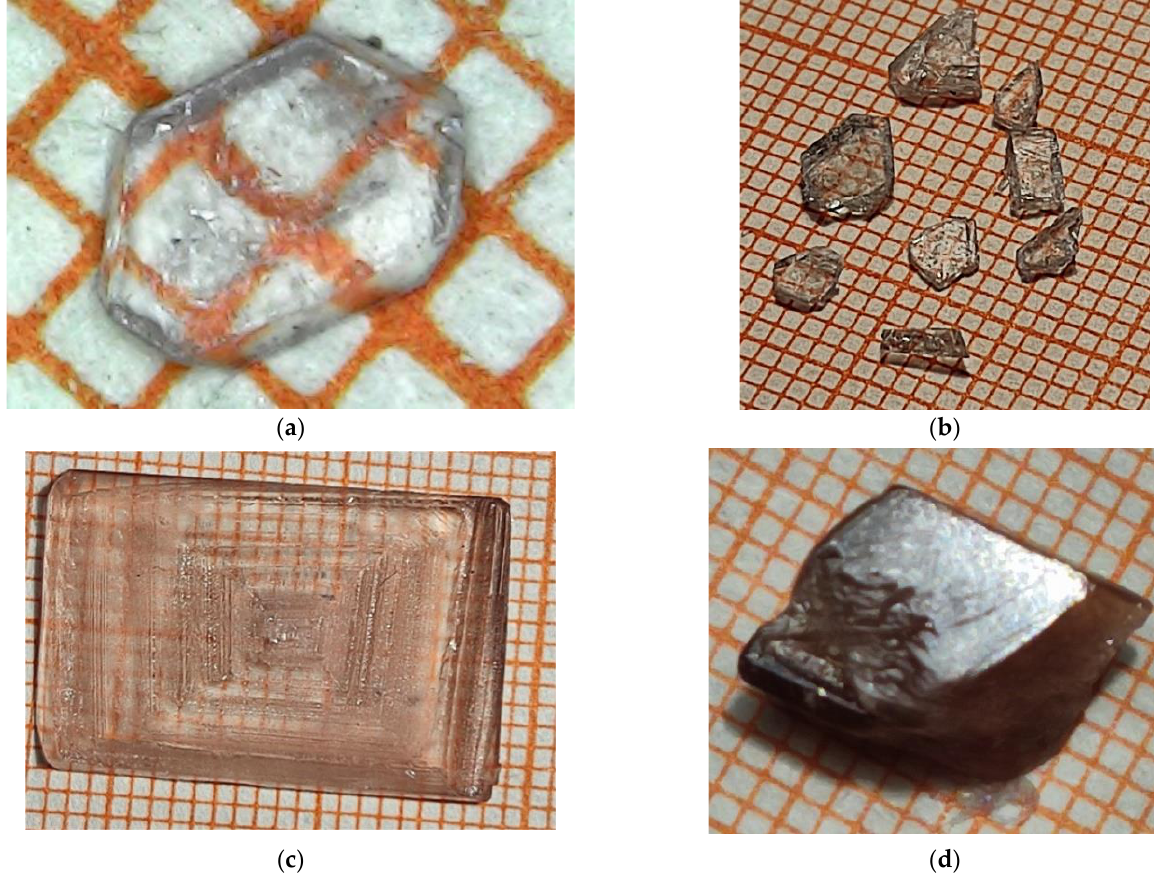
Figure 1. Optical images of grown MBI-perchlorate crystals. Samples 1 ( a , b ), 2 ( c ), and 3 ( d ). The sizes of the grid steps in ( a – d ) are equal to 1 mm.